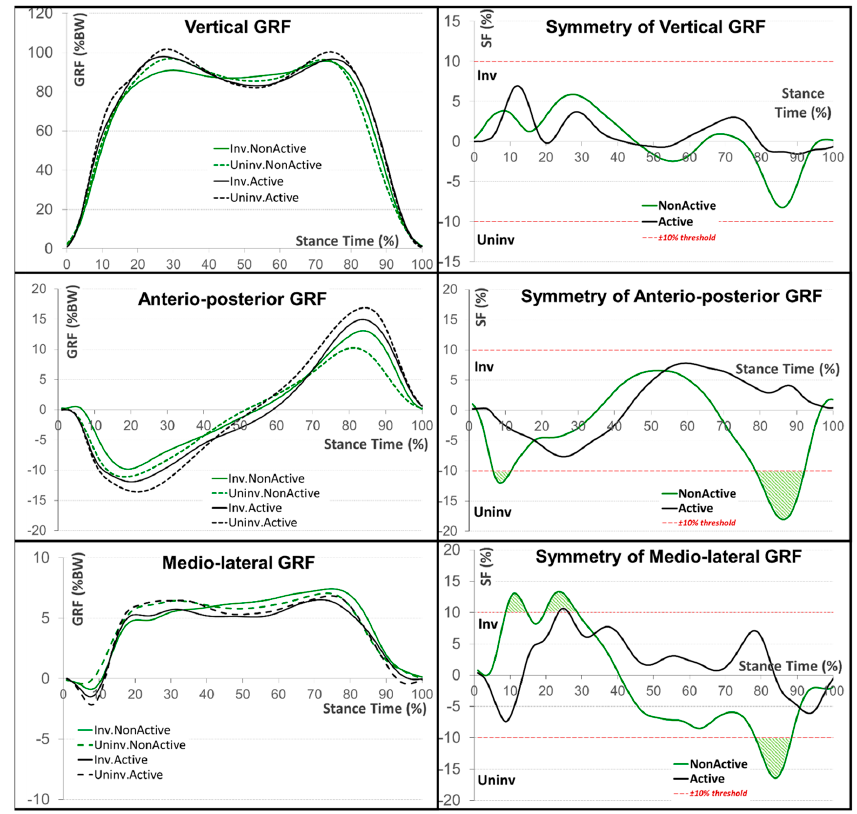
Figure 5. Ground reaction force components (in % of body weight) for both involved/uninvolved limbs and active/non-active groups ( on the left ); corresponding symmetry function (SF) for the active/non-active groups ( on the right ). The ±10% threshold was postulated to discriminate between symmetrical and asymmetrical patterns. All angles are in degrees and the SF in percentage. Table 3. GRF results. Median, minimal, and maximal values and ±median absolute deviation (±MAD).